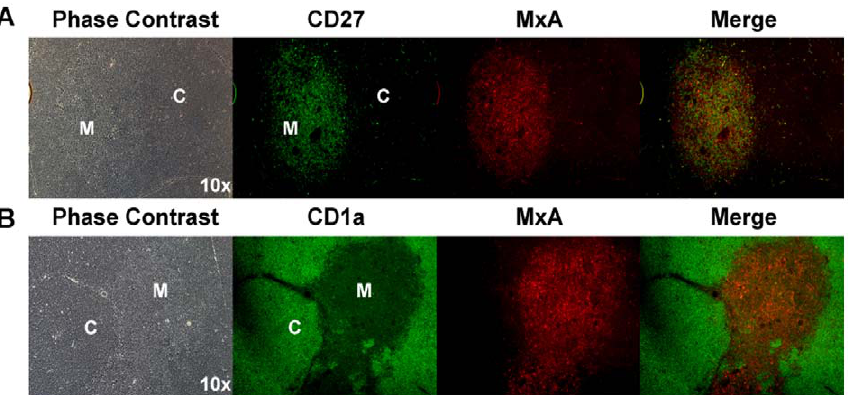
Figure 2. MxA is expressed in the thymic medulla. Postnatal thymus tissue was formalin fixed and paraffin embedded. 4 um sections were mounted on slides. A , Thymus tissue was stained with CD1a and MxA followed by Goat anti-mouse IgG1 Alexa Fluor 488 and Goat anti-mouse IgG2a Alexa Fluor 594. B , Thymus tissue was stained with antibodies directed against CD27 and MxA followed by Goat ant-mouse IgG1 Alexa Fluor 488 and Goat anti-mouse IgG2a Alexa Fluor 594.